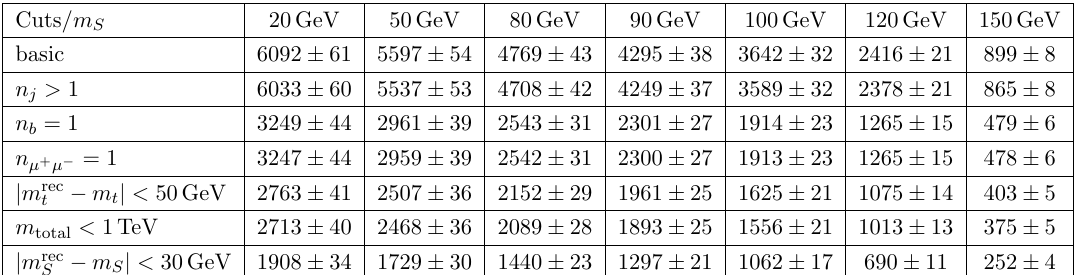
Table 1 . Event yields after each cut for the seven benchmark signal points, in the analysis for t ! Su; S ! (cid:22) + (cid:22) (cid:0) . We (cid:12)x Y 13 = Y 31 = 0 : 1, (cid:3) = 1 TeV and B ( S ! (cid:22) + (cid:22) (cid:0) ) = 1. The event yields presented assume a collected luminosity of L = 150 fb (cid:0) 1 .